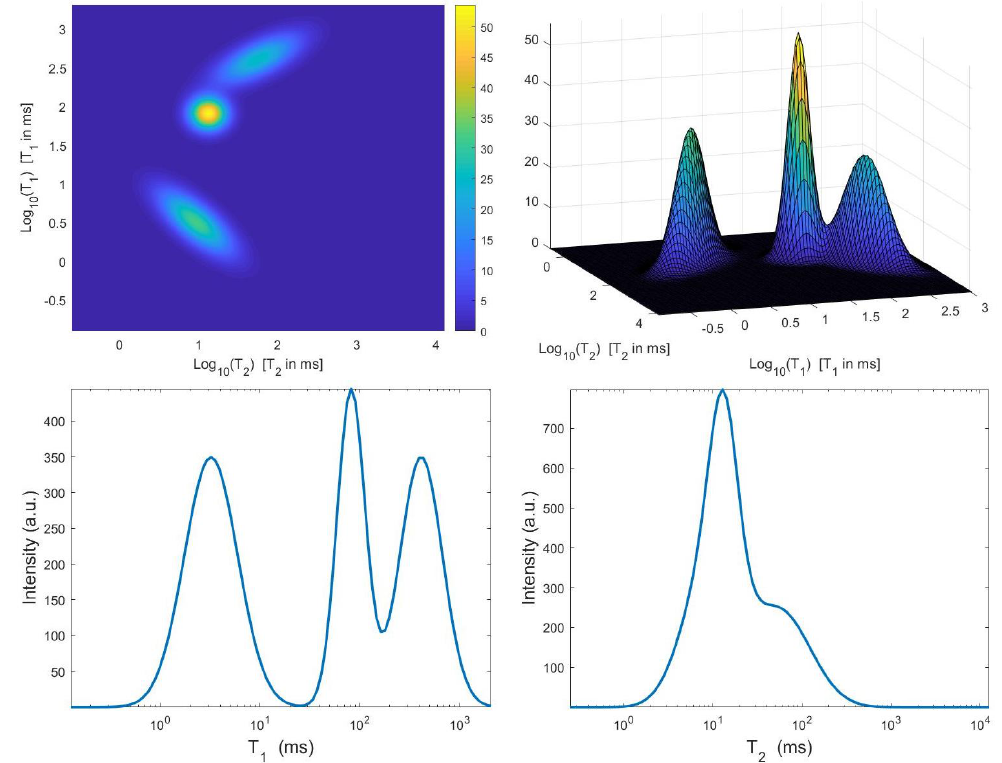
Figure 2. Top : simulated T 1 – T 2 map and surface distribution. Bottom : projections along the T 1 and T 2 dimensions.